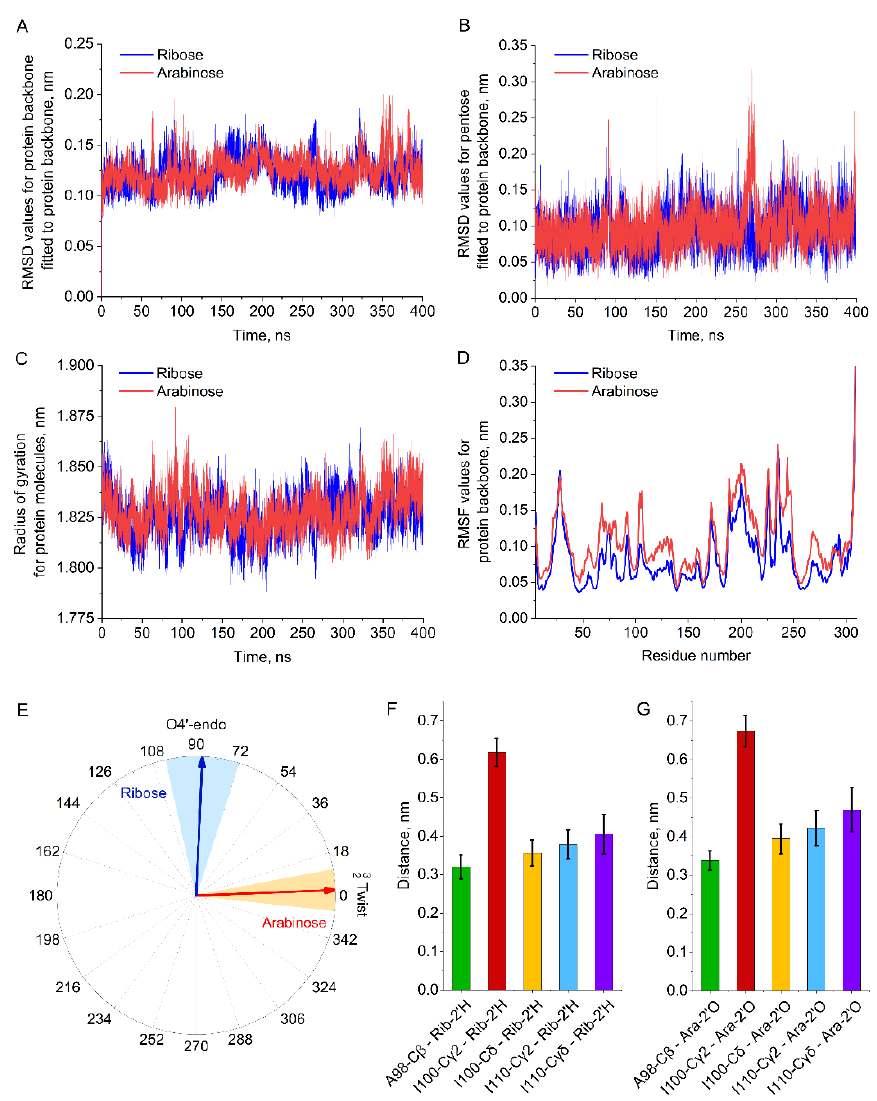
Figure 4. ( A )—RMSD values for protein backbone fitted to protein backbone ( B )—RMSD values for pentose molecule fitted to protein backbone ( C )—radius of gyration for the protein molecule ( D )—RMSF profile for the protein backbone ( E )—pseudorotation coordinates for the furanose ring of ribose/arabinose (mean value and standard deviation) ( F )—Distances between 2′ -hydrogen atom of ribose and various atoms of Eco RK active site (mean values and standard deviation) ( G )—Distances between 2′ -oxygen atom of arabinose and various atoms of Eco RK active site (mean values and standard deviation).